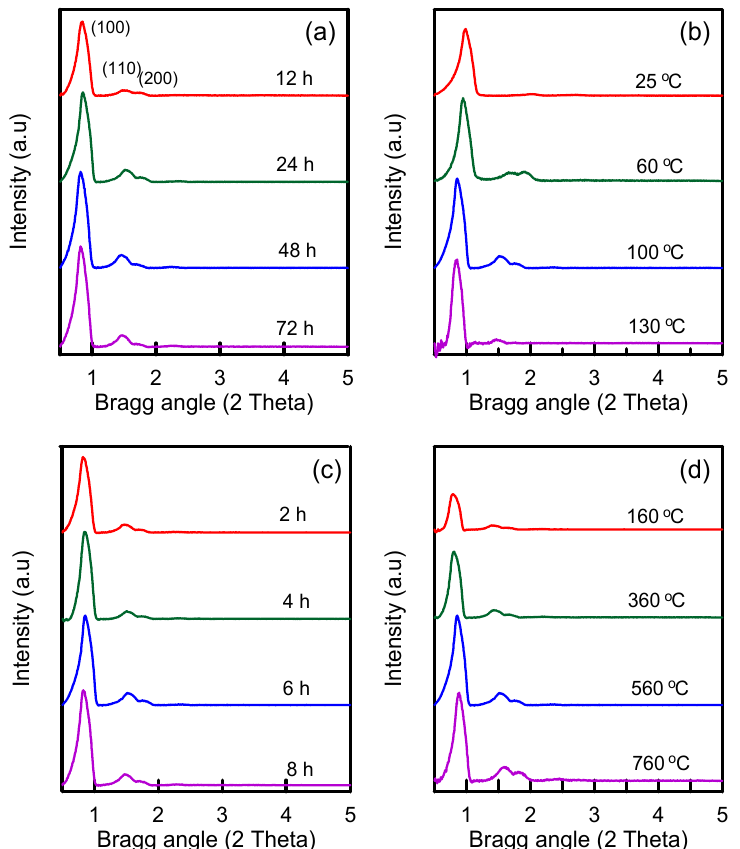
Figure 2. XRD images of SBA ‐ 15 samples prepared under various synthesis conditions: ( a ) Hydrothermal treatment time; ( b ) hydrothermal treatment temperature; ( c ) calcination time; ( d ) calcination temperature.